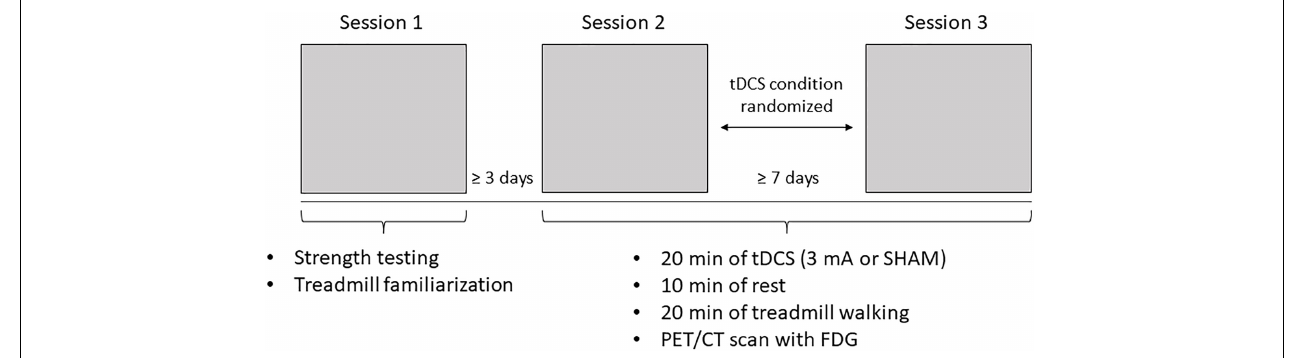
FIGURE 1 | Experimental protocol. Subjects attended three sessions. Sessions 1 and 2 were spaced at least 3 days apart and Sessions 2 and 3 were spaced at least 7 days apart. During Session 1, subjects completed strength testing to objectively determine their more-affected leg and treadmill familiarization. During Sessions 2 and 3, subjects underwent 20 inin of either Sham or 3 mA Ml tDCS (determined through randomization), followed by 20 inin of treadmill walking after a 10 inin rest, then a whole body positron emission tomography/computer tomography (PET/CT) scan with fluorodcoxyglucosc